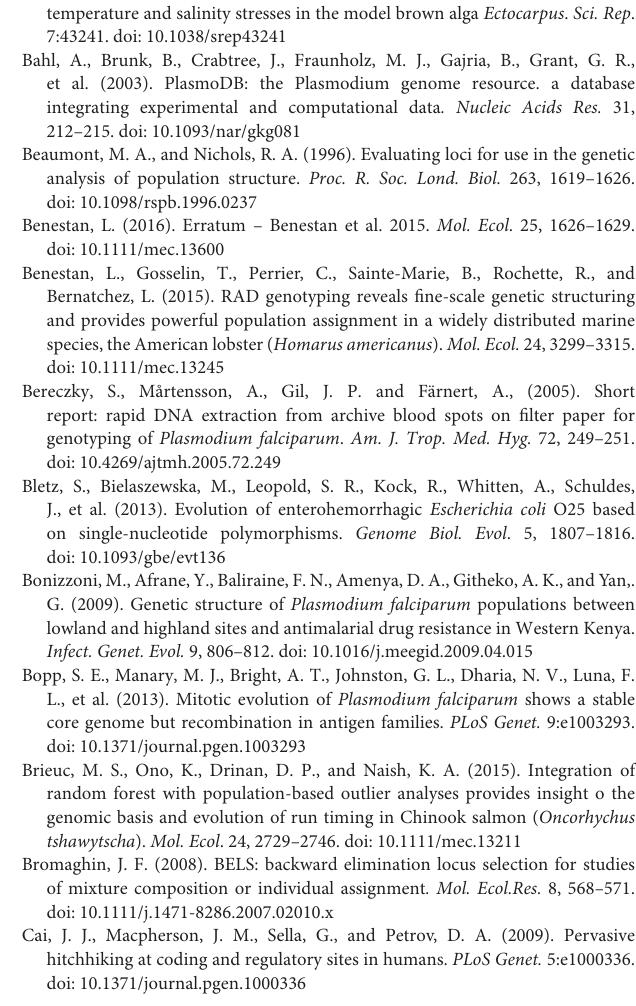
Supplementary Figure 3 | Log-likelihood plots for assignment for first generation migrants between populations from the north and south. Red dots denote